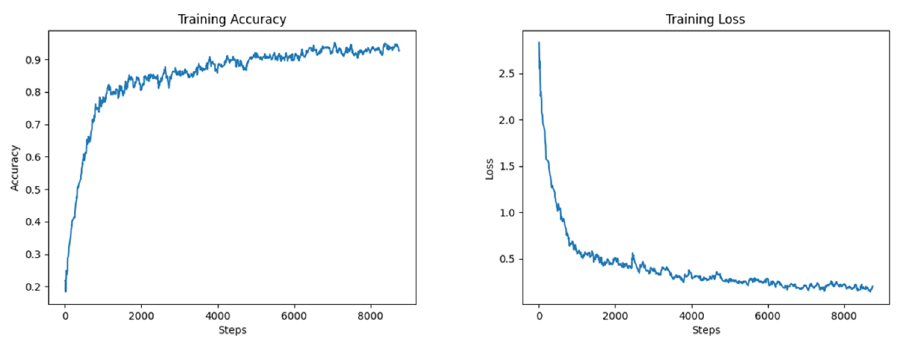
Figure 10. Changes in the accuracy and loss of the training set with the step size.